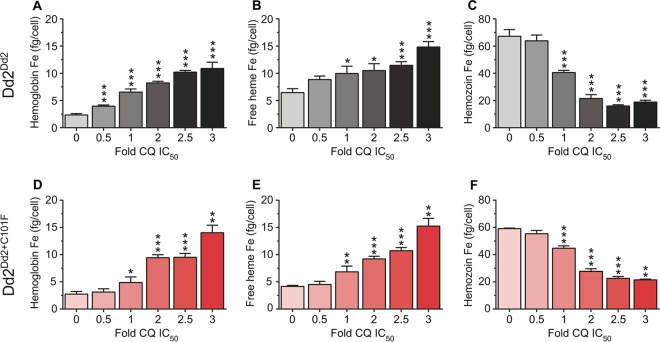
Heme fractionation of chloroquine (CQ)-treated Dd2Dd2 and Dd2Dd2+C101F (clone 1). (A to C) Amounts of (A) hemoglobin Fe (femtograms per cell), (B) free heme Fe (femtograms per cell), and (C) hemozoin Fe (femtograms per cell) present in Dd2Dd2 treated with increasing concentrations of CQ (used at multiples of the Dd2Dd2 CQ IC50). (D to F) Amounts of (D) hemoglobin Fe, (E) free heme Fe, and (F) hemozoin Fe present in Dd2Dd2+C101F parasites treated with multiples of their CQ IC50. Data (calculated from 6 to 8 values per concentration) are presented and statistically analyzed as per Fig. 4.